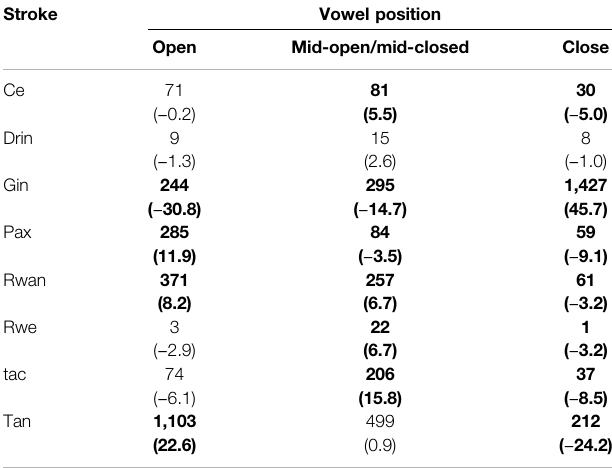
corresponding Wolof phrases. Two different hypotheses — the word- level hypothesis and the syllable-level hypothesis — were examined.